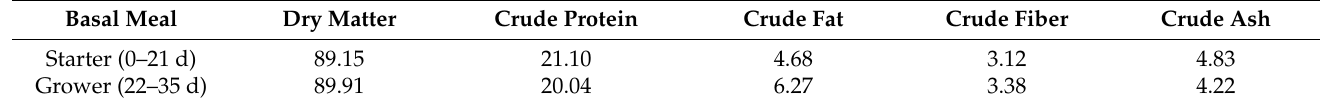
Table 2. Proximal analysis of starter and grower basal diets, % (as-fed basis).